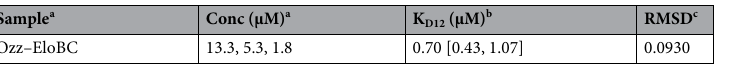
Table 4. AUC-SV: summary of the isotherm sedimentation velocity analysis of Ozz–EloBC in 10 mM sodium phosphate, 1.8 mM potassium phosphate pH 7.2, 137 mM NaCl and 0.27 mM KCl buffer at 20 °C. Model: monomer–dimer self-association. a Total concentration of the integrated monomer–dimer c ( s ) peaks. b Dissociation constant K ‐ D12 of the monomer–dimer self-association reaction. For the isotherm signal weighted-average sedimentation coefficient values were obtained by integration of the c ( s ) distributions between 3 and 7 S at various concentrations 17,22 . The s ‐ values for monomer and dimer, s 1 and s 2 (3.82 S and 5.75 S) were fixed while the K 12 the equilibrium association constant was optimized in the fit (Theoretical molar mass: 57,285 Da). Errors of the constant represent the 68% confidence interval (CI) using an automated surface projection method 23 . c Root mean square deviation of the fit, units in fringes for the reversible dimer formation.